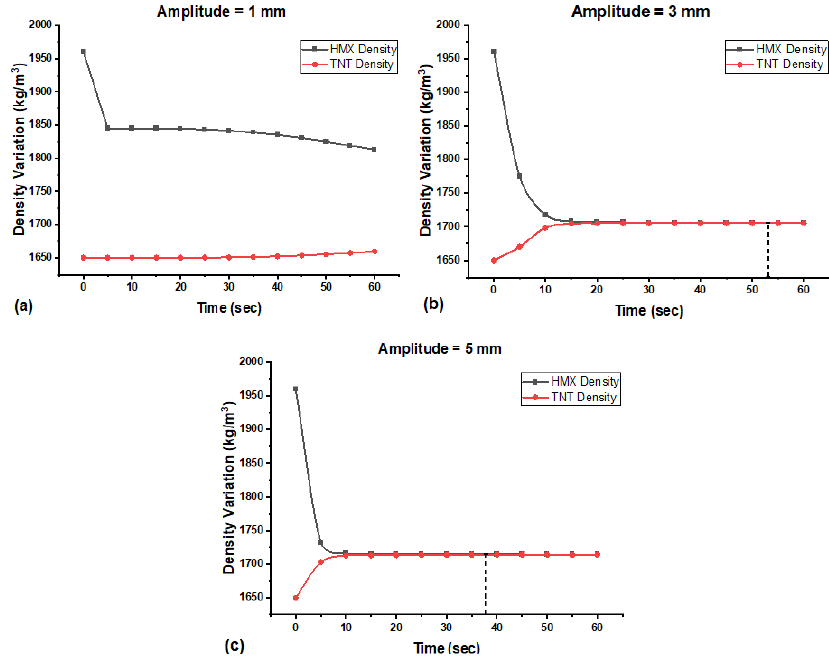
Figure 10. Plots of density variation from (a ‒ c) over different values of amplitude. For the simulation of 1 mm amplitude, the density difference was 152.79 kg/m 3 after 60 s, therefore, with these parameters, the mixing efficiency was totally undesirable. Sim- ilarly, for the 3 mm amplitude, the density difference after 60 s was 0.40 kg/m 3 . Therefore, uniform mixture was achieved after 56 s. When the amplitude was 5 mm, the results showed that the density difference after 60 s was 0.11 kg/m 3 , which suits the standards set for uniform mixing, and a uniform mixture could be achieved after 38 s. The results were compared with each other which showed that lager amplitudes en- hanced mixing efficiency. When the value of amplitude was 5 mm, the time required for uniform mixing was 38 s; when the amplitude was 3 mm, the time required was 56 s; and when amplitude was 1 mm, the time required was 98 s. The bigger the amplitude’s value, the better the mixing efficiency. The comparison is displayed in Figure 11. Figure 11. Mixing efficiency comparison based on amplitude. 3.2.2. Effects of Frequency on the Mixing Process Mixing efficiency was analyzed for different values of frequency from 20 Hz, 40 Hz, to 60 Hz whereas the other parameters, such as amplitude and mixing time, were set as